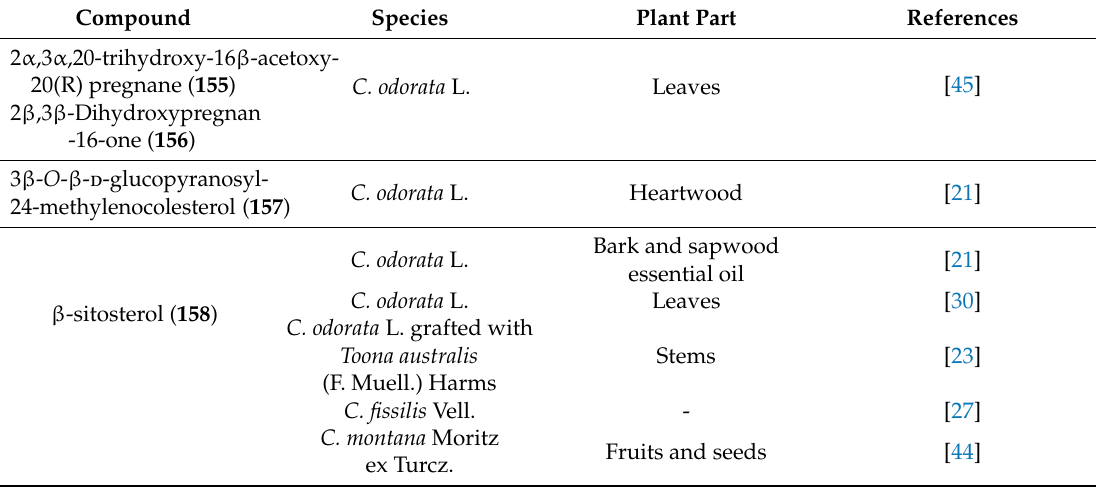
Table 8. Steroids isolated from the genus Cedrela (1960–2020).